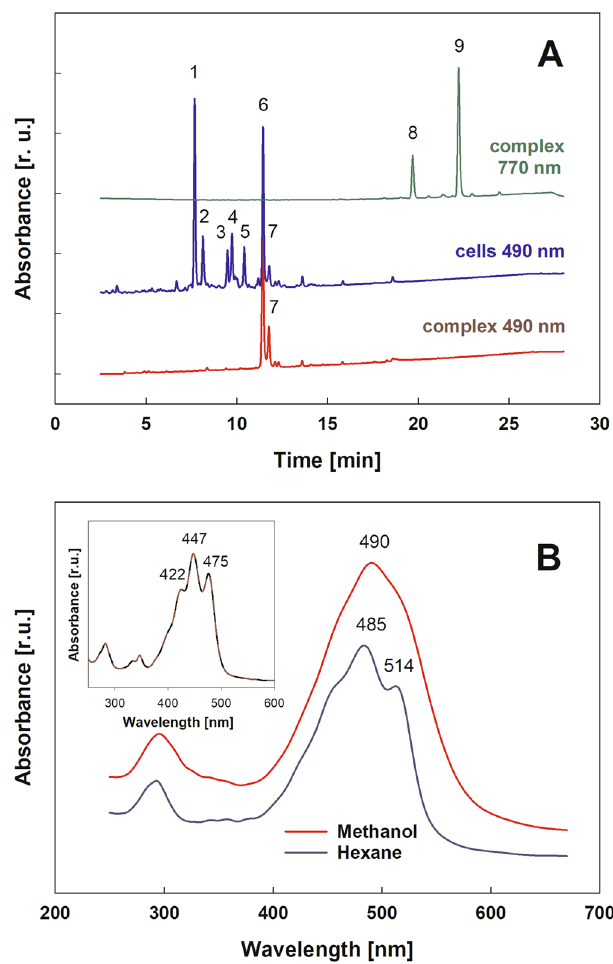
Figure 1. ( A ) HPLC elution profile of Gemmatimonas phototrophica AP64 whole-cell extract (green and blue trace) and of the isolated photosystems (red trace) at 490 nm for carotenoids and 770 nm for bacteriochlorophyll, respectively. Identified peaks: 1 and 2, putative (2 S ,2 ′ S )-oscillol 2,2 ′